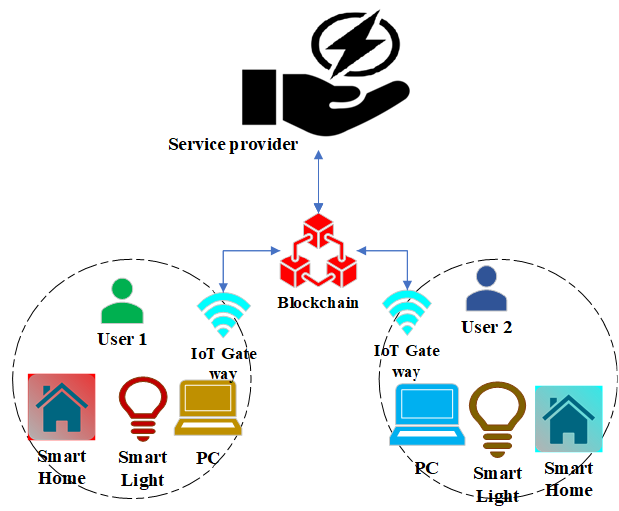
Figure 3. Blockchain’s overarching design for HA .